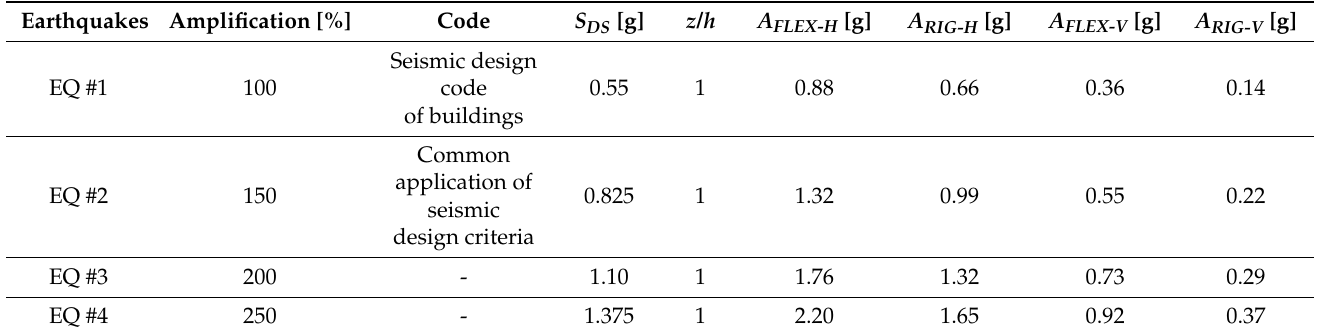
Table 4. Parameters used to generate